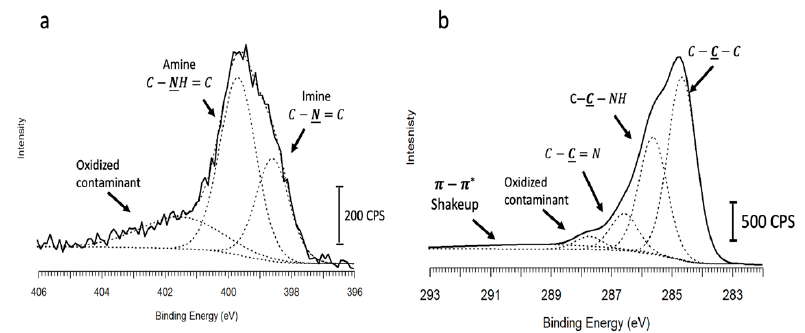
Figure 3. XPS spectra fit before sputtering of the nitrogen 1s ( a ) and carbon 1s ( b ).